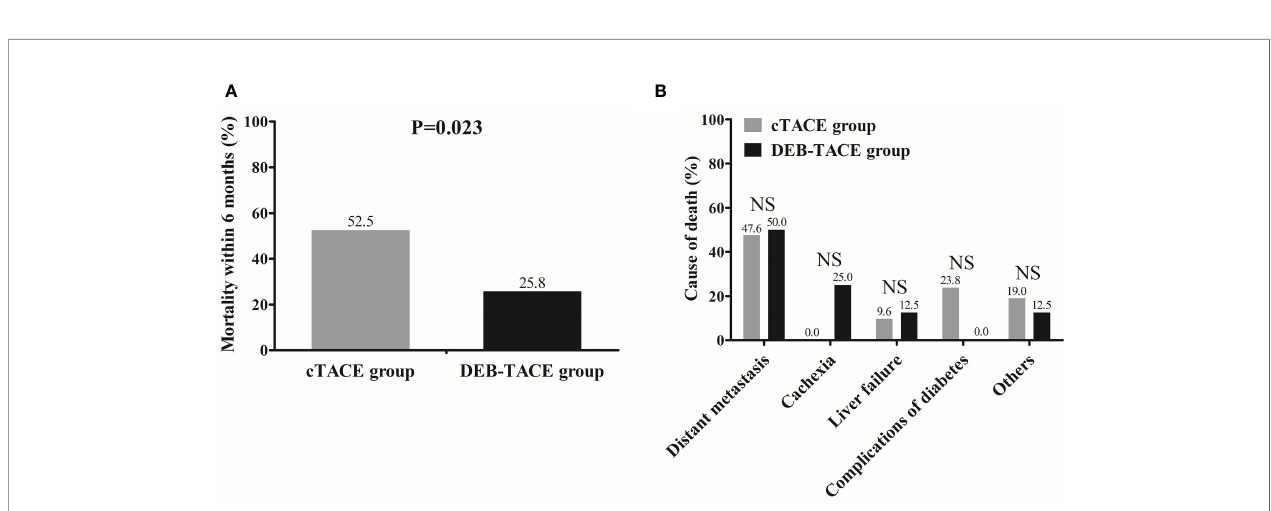
FIGURE 3 | Mortality and death causes between the DEB-TACE and cTACE groups. Mortality within 6 months was lower in the DEB-TACE group compared with cTACE group (A) , and there was no difference in death causes between the two groups (B) . Comparison of mortality rate as well as death causes between two groups was determined by Chi-square test. p < 0.05 was considered signi fi cant. NS, not signi fi cant; DEB-TACE, drug-eluting bead transarterial chemoembolization; cTACE, conventional transarterial